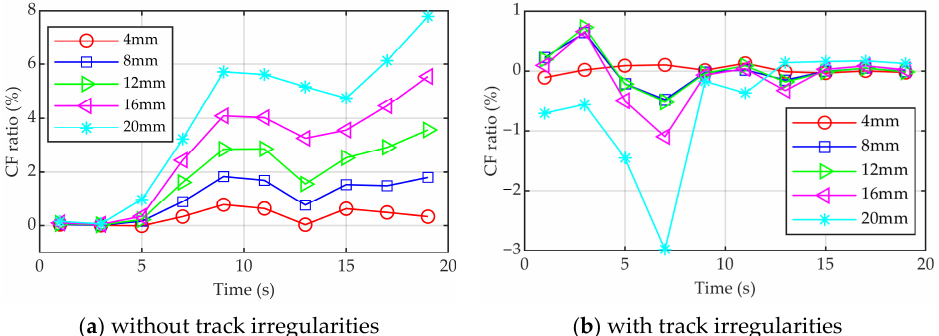
Figure 9. Feature evolution of vertical vibration of the fi rst gearbox housing under traction condition.